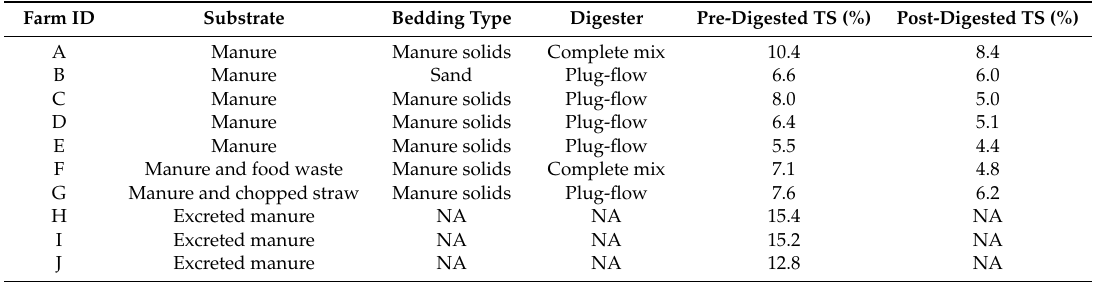
Table 2. Farm management practices and total solids (TS) content of undiluted